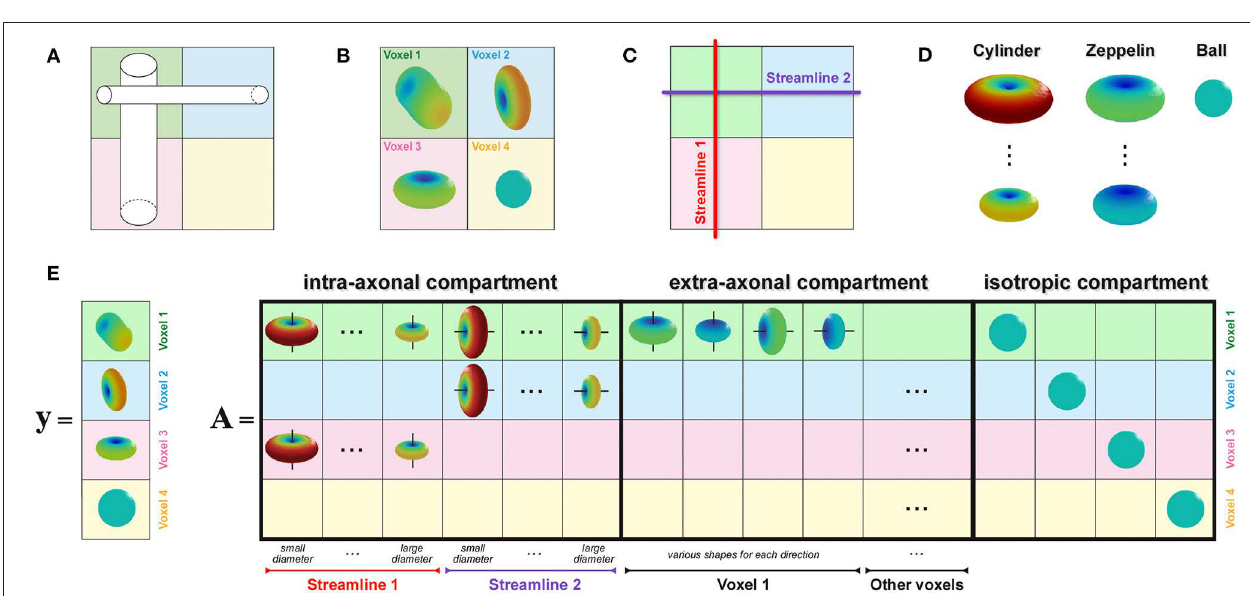
FIGURE 2 | How to enable estimation of bundle-specific axon diameter index. (A) Simple crossing configuration of two fiber populations with different axon compositions, i.e., the vertical one is composed of larger axons than the horizontal, to illustrate the construction of the proposed formulation. (B) Corresponding DW-MRI signal in four representative voxels. (C) Example of two possible streamlines reconstructed with tractography. (D) Visual representation of the response functions in the Cylinder-Zeppelin-Ball forward model for each compartment. (E) The vector y contains a concatenation of the DW-MRI signal acquired in all voxels, while the matrix A is constructed by combining the response functions with the local orientations of the streamlines in each voxel.